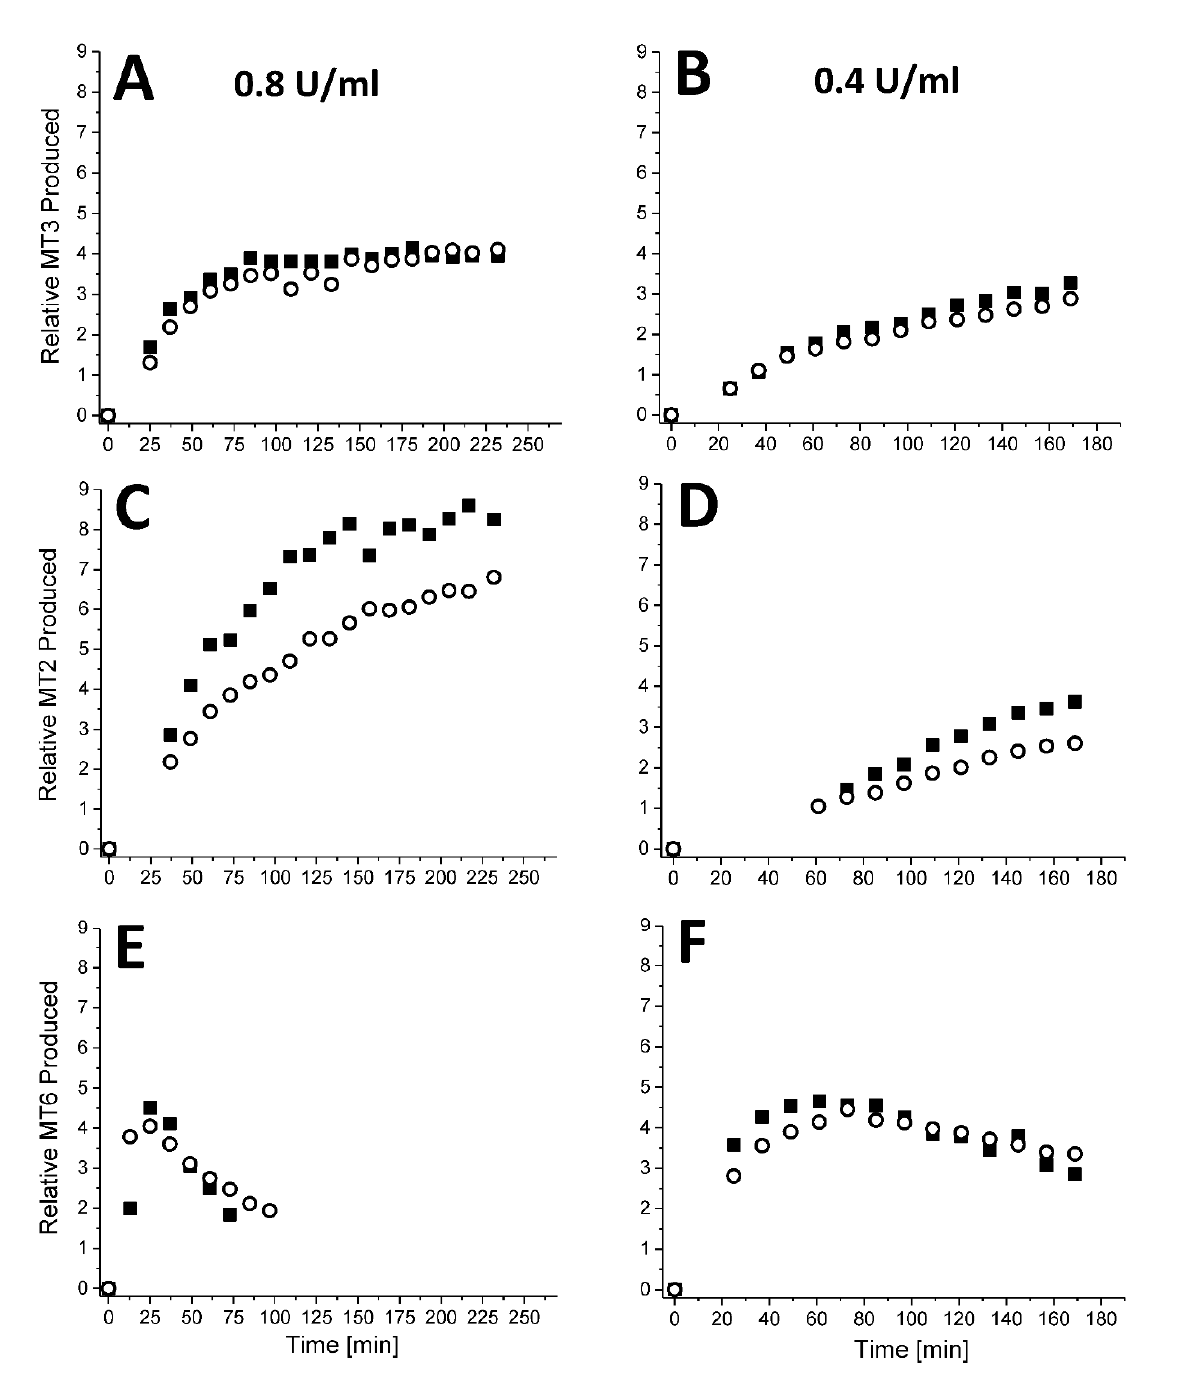
Figure 6. Using the 13 C HSQC spectra as shown in Figure 5, peak volume integrals were determined and plotted individually for MT3 ( A , B ), MT2 ( C , D ), and MT6 ( E , F ) as a function of the time of hydrolysis of amylopectin mediated by α -amylase at 0.8 U/mL ( A , C , E ) and 0.4 U/mL ( B , D , F ). Data are shown for kinetic runs performed in the absence (filled squares) and presence of PLG ‐ 007 at a concentration of 4.2 mg/mL (open circles). Solution conditions are 20 mM potassium phosphate, pH 7, 30 °C.